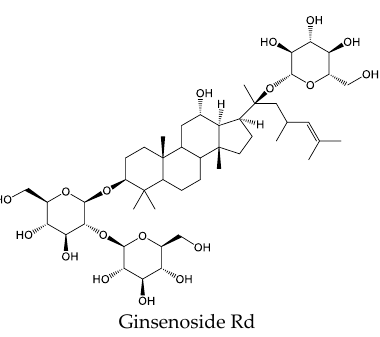
Figure 1. Chemical structures of aspirin, salicylic acid, notoginsenoside R 1 and ginsenoside Rg 1 , Rb 1 , Re, Rd.